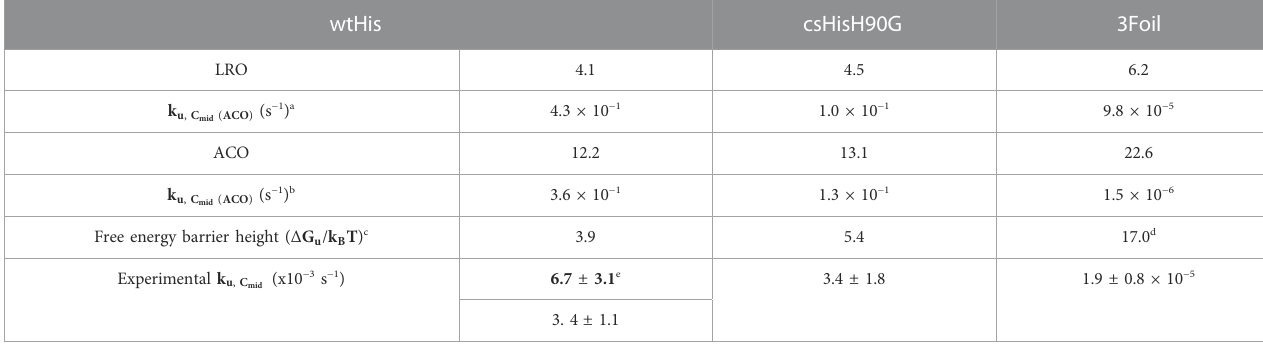
TABLE 1 Predicted and experimental protein unfolding